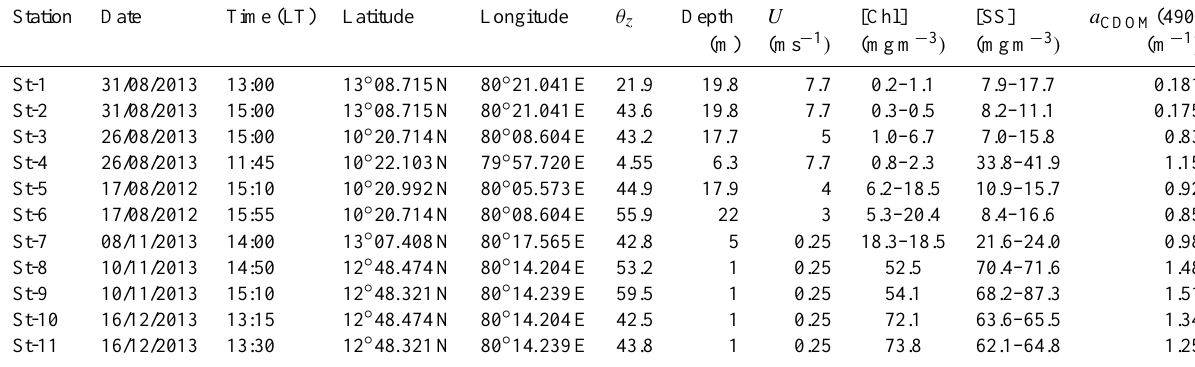
Table 2. Station details and the observed environmental parameters used for this study. Station